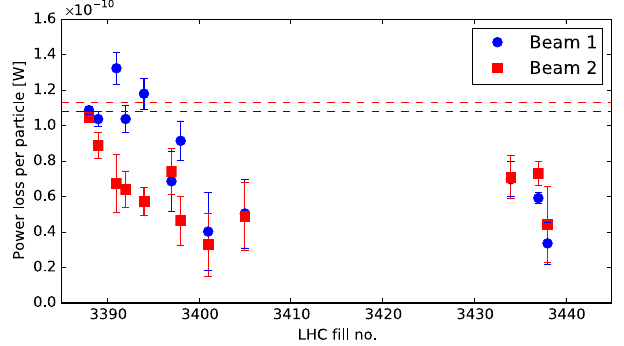
FIG. 14. Evolution of the maximum power loss per particle P p during the 2012 scrubbing run at 450 GeV with 25 ns beams for Beam 1 (blue circles) and for Beam 2 (red squares). The dashed lines represent the level achieved after the scrubbing run in 2011 for both beams. The decrease in power loss is a clear indicator of the SEY reduction. Error bars are defined by the noise of the bunch-by-bunch phase measurements.